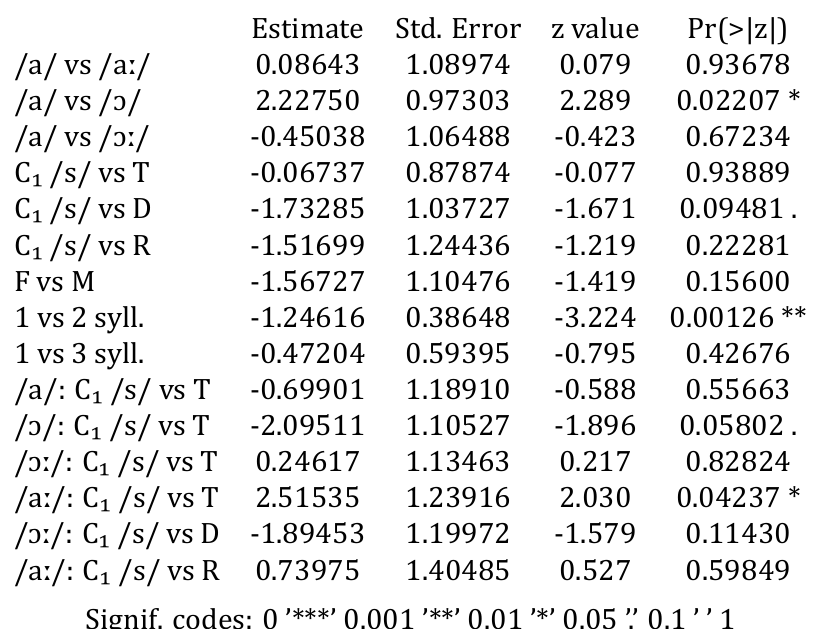
Table A.18: Pre-aspiration occurrence prior to C₂ fortis plosive as a dependent variable